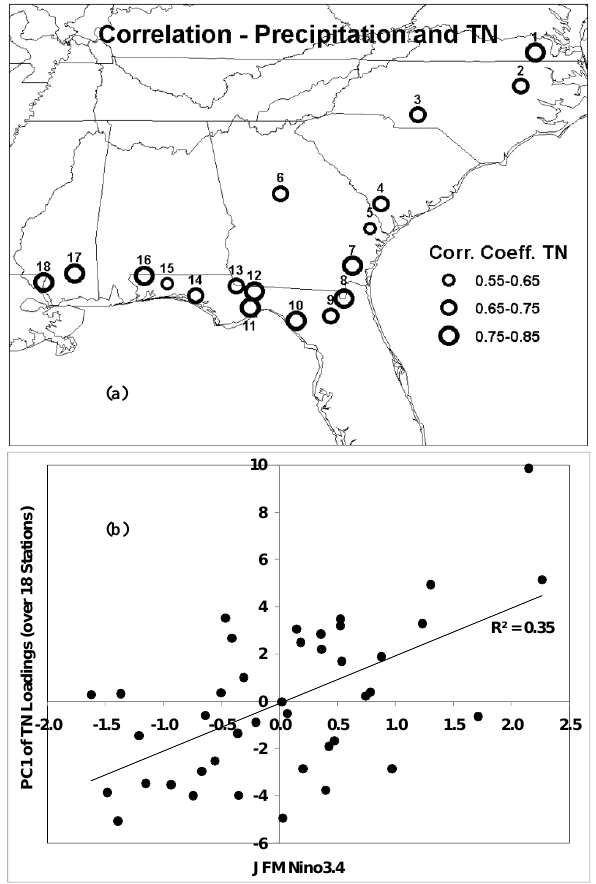
Figure 2: Rank correlation between the simulated total nitrogen (TN) loadings from the LOADEST model and observed precipitation (a) and the association between El Nino Southern Oscillation (ENSO) index – Nino3.4 – and the first principal component (PC1) of TN loadings (b) over the selected 18